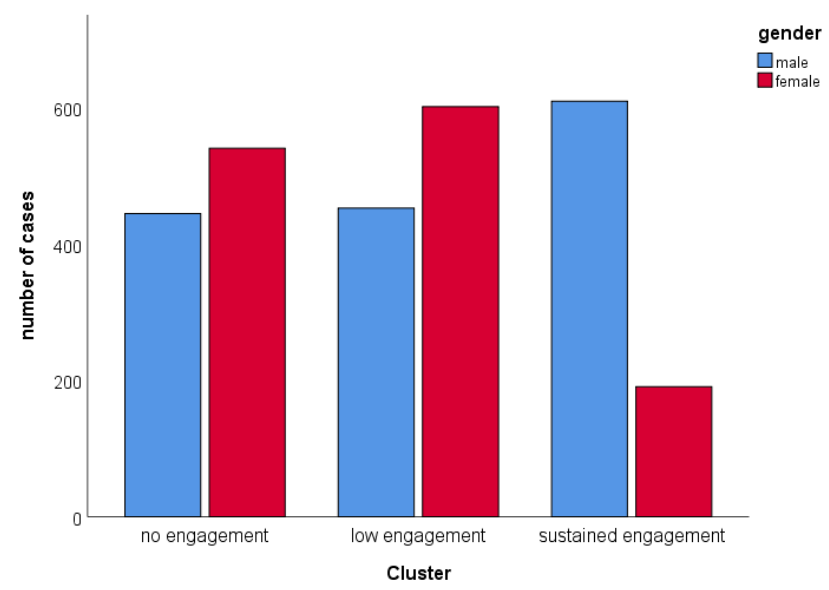
Figure 2. Gender comparison concerning the three clusters of engagement in CS projects.